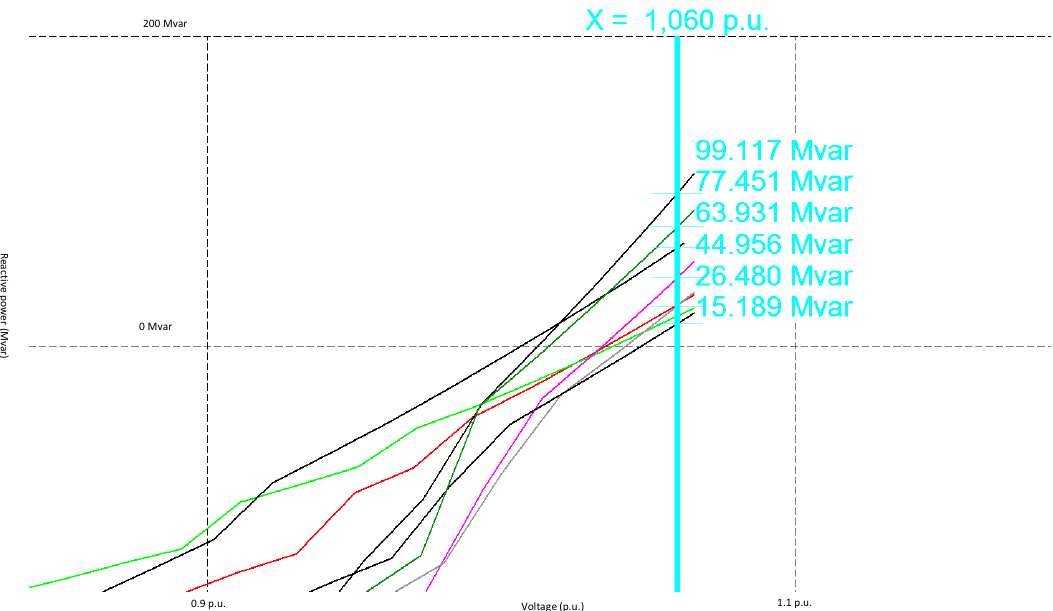
Figure 9. QV-analysis of the 3rd contingency, in the southern area of Zealand, after the added 100 Mvar Figure 9. QV ‐ analysis of the 3 rd contingency, in the southern area of Zealand, after the added 100 reactor split on two reactors at VLO and ESK. Mvar reactor split on two reactors at VLO and ESK. Table 5. The comparison between the two cases of reactive power compensation.